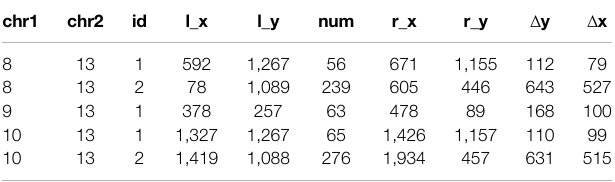
TABLE 1 | Partial data of grape chromosome 13 cluster.csv fi le. TABLE 2 | Partial data of grape chromosome 13 combine.csv fi